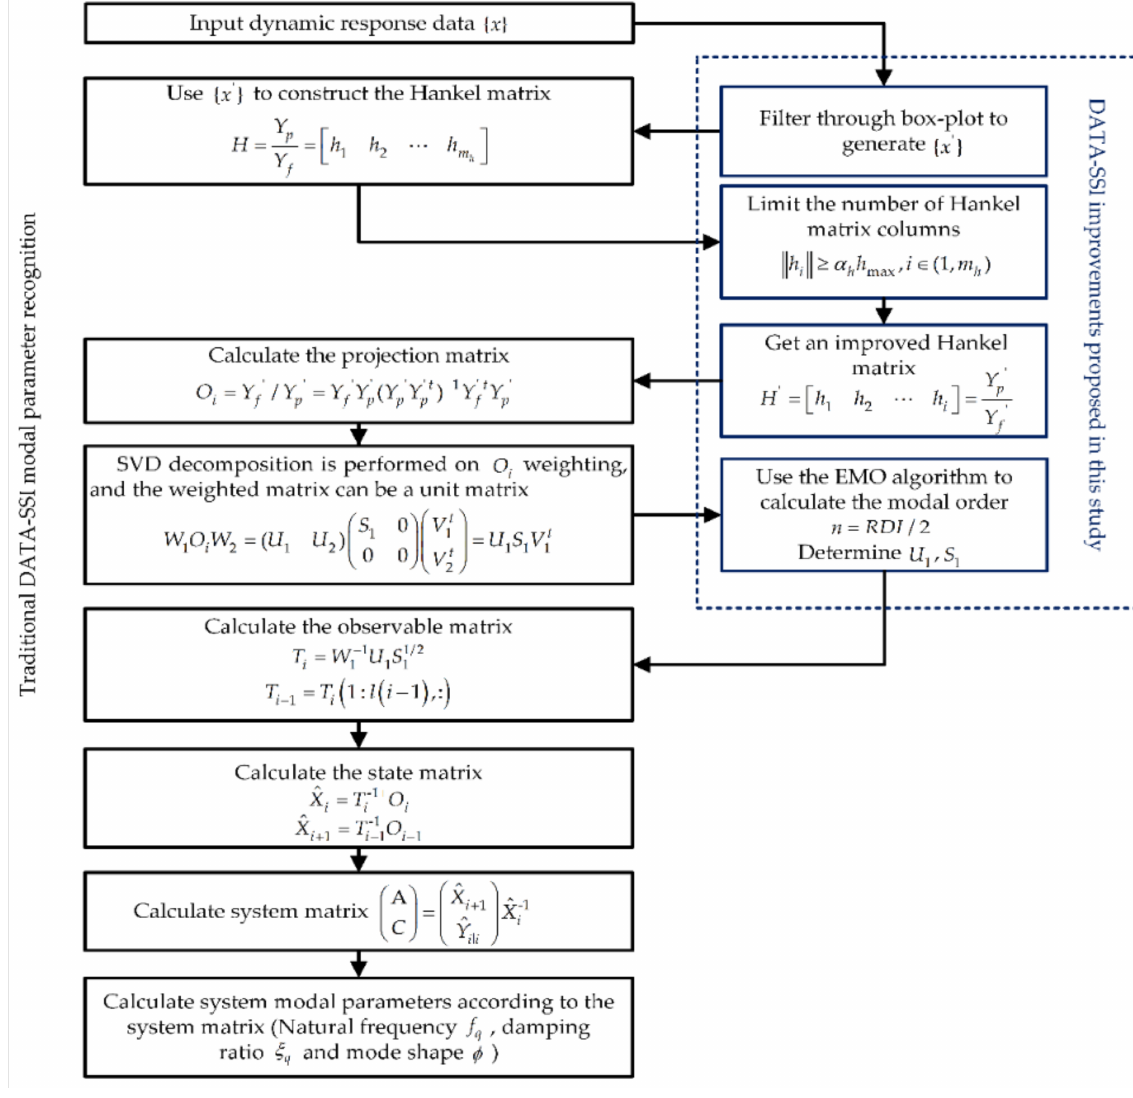
Figure 1. Workflow of the improved Data-SSI